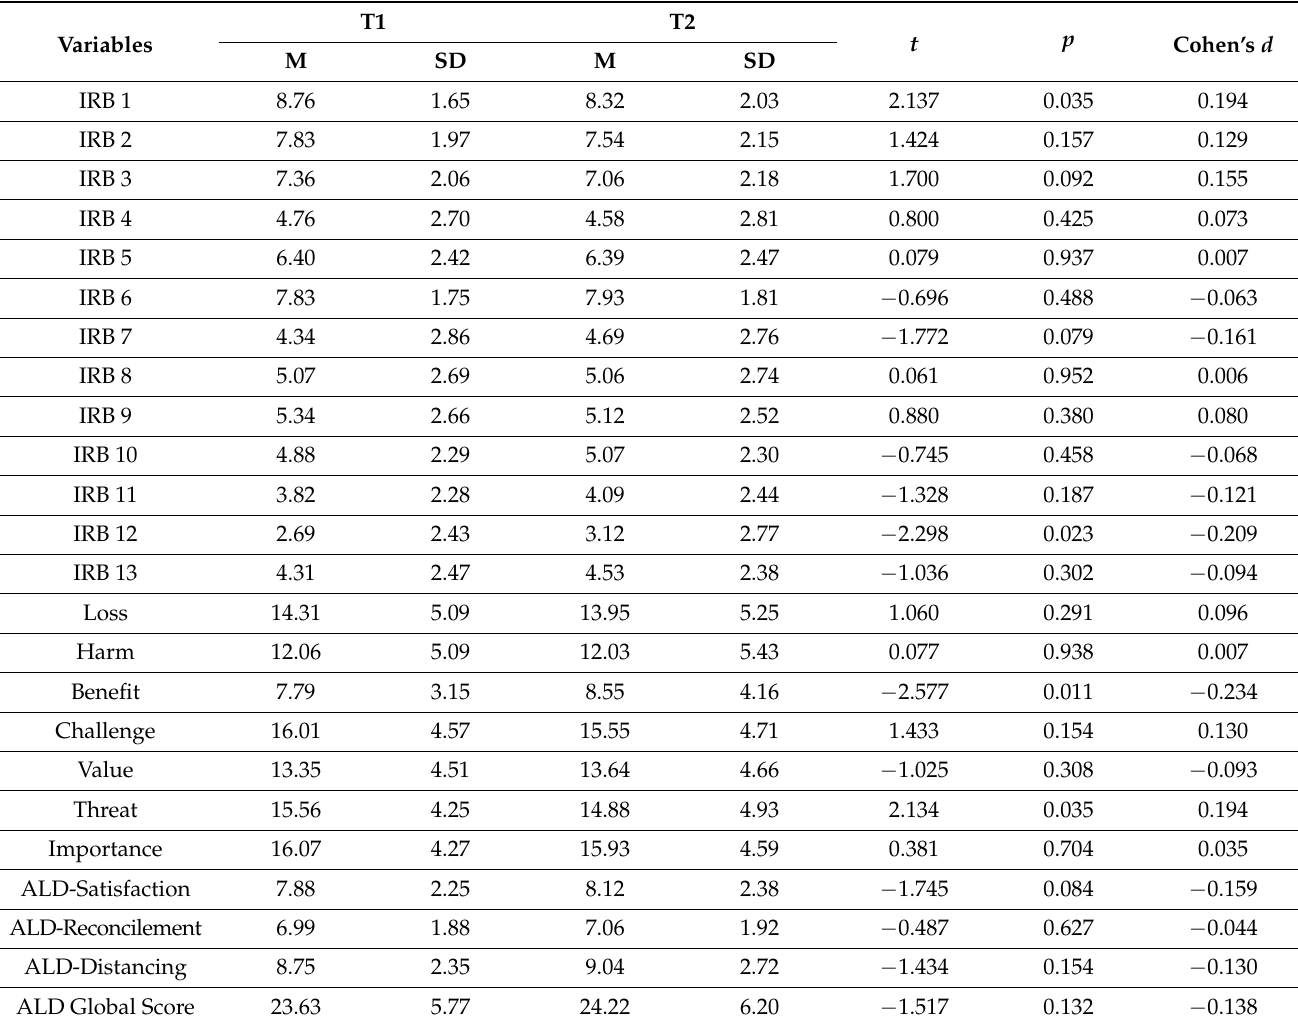
Table 4. Differences between T1 and